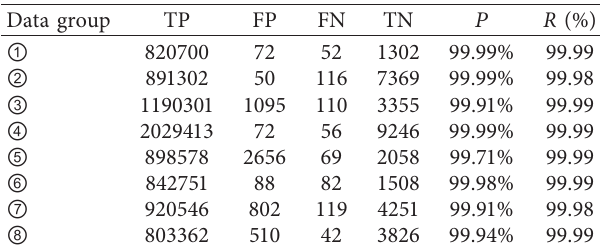
Figure 9: The results of point cloud denoising for roller with the contact surface width of 4mm. (a) The result by using conditional denoising. (b) The result by using statistical denoising. (c) The result by using the conditional and statistical method. Table 3: Calculation of precision rate P and recall rate R of the denoising algorithm in the present